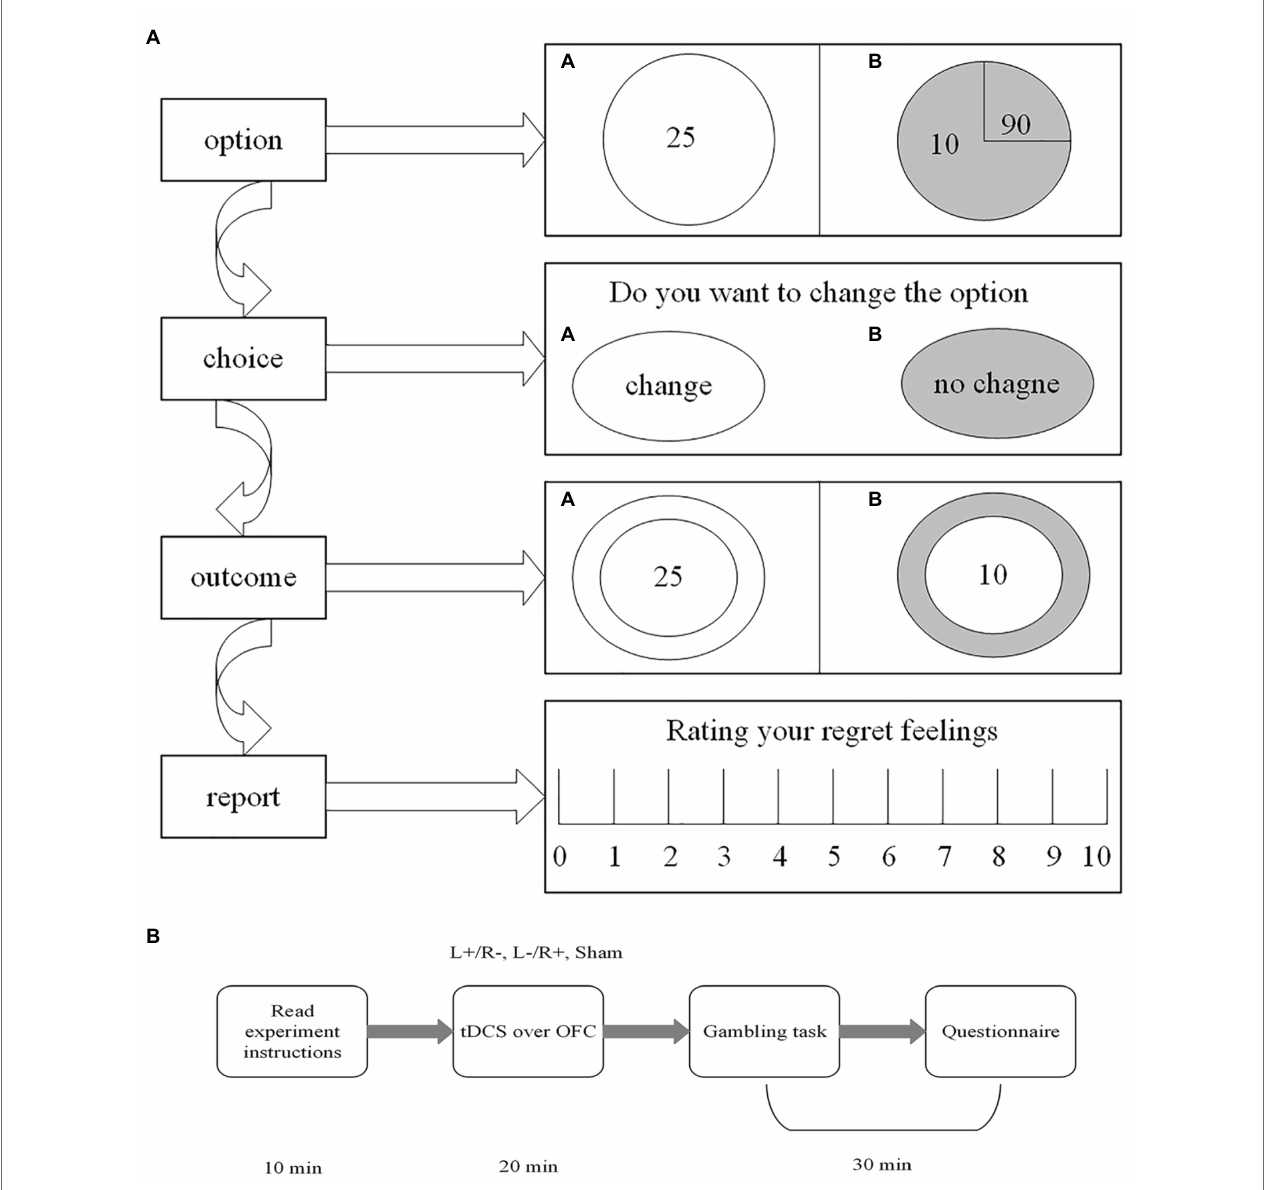
FIGURE 3 | The gambling task and the experimental procedure. (A) The gambling task. First, option B was established by computer. Second, the subjects were asked whether they wanted to change the computer’s option. Third, the obtained outcome and the unobtained outcome were presented by the computer. Fourth, the participants were asked to report their regret feelings. (B) The experimental